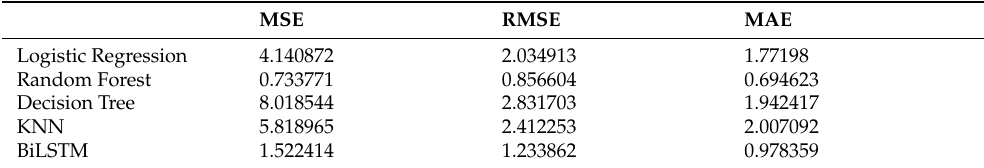
Table 5. Mean Squared Error (MSE), Root Mean Square Error (RMSE), and Mean Absolute Error (MAE) for scenario 4 with the regression method (Y =